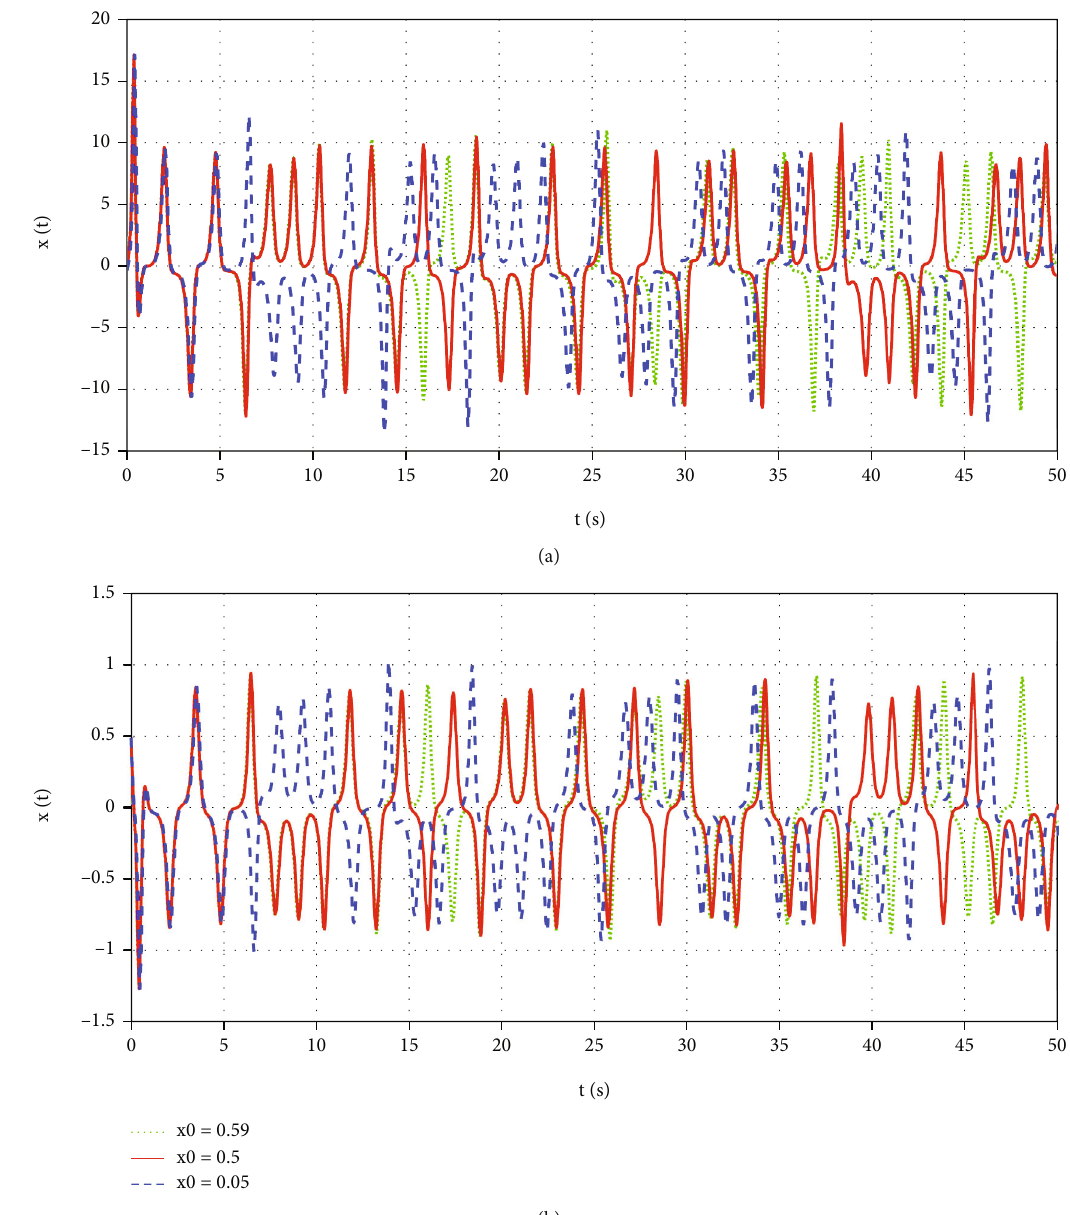
Figure 14: The time series solution of LS (5) corresponding to di ff erent initial conditions due to di ff erent values of x